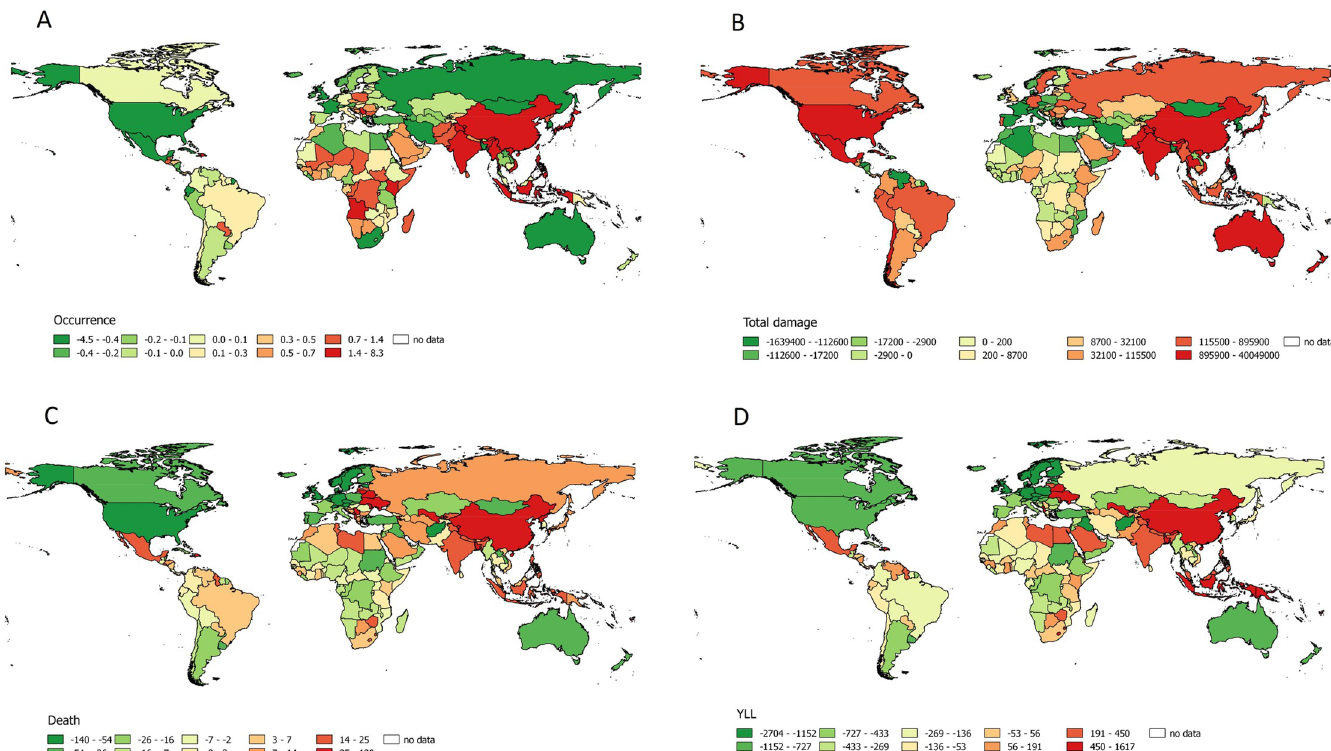
Fig 1. Map of trends in natural disasters and IHD from 1990 to 2017 in 193 countries. (A) Trend in the occurrence of natural disasters, per year. (B) Trend in total damage due to natural disasters, 1000 US$ per year. (C) Trend in mortality due to IHD for both sexes per 100,000 population per year. (D) Trend in YLL due to IHD for both sexes per 100,000 population per year.